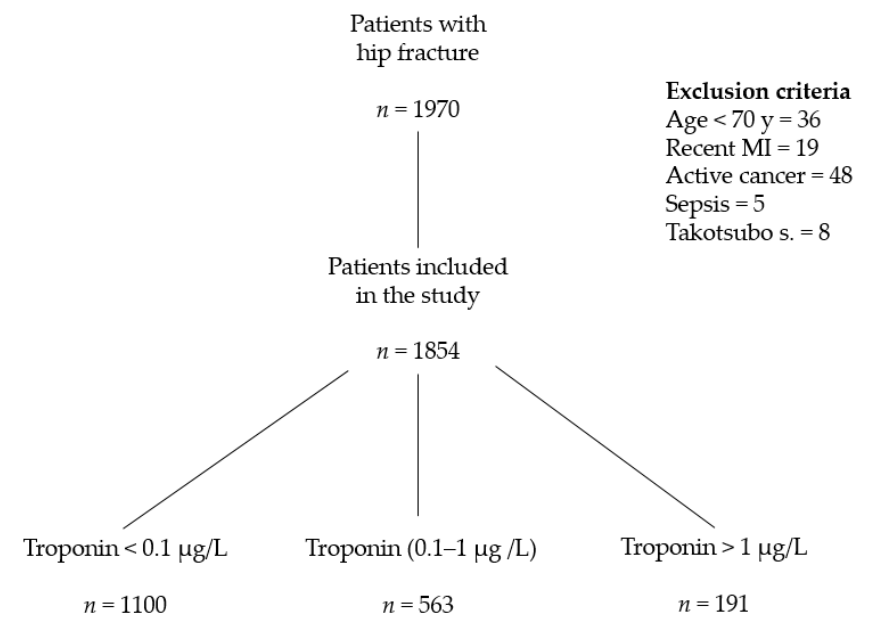
Figure 1. Patients included in the study.